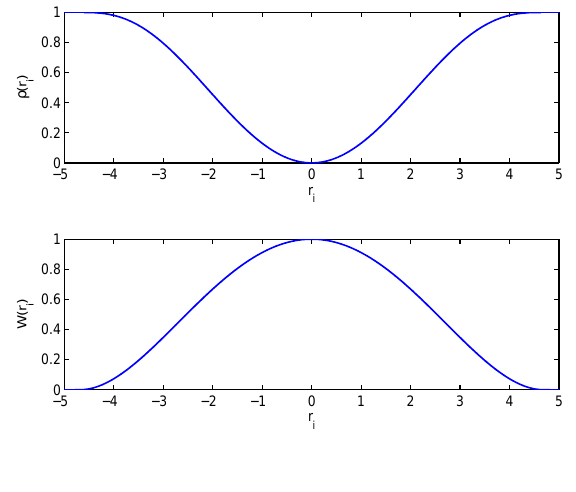
Figure 2. Biweight function and its corresponding weighting